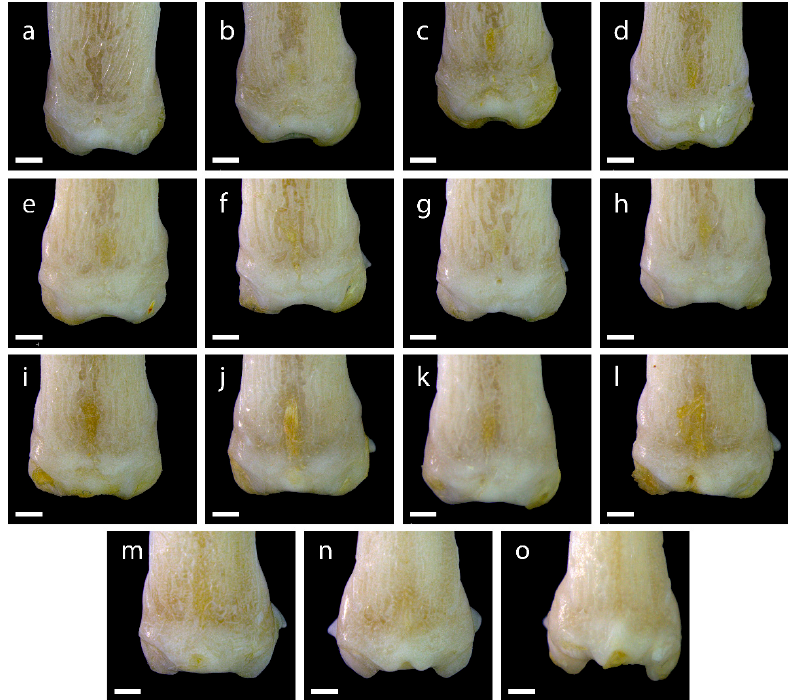
Figure A10. Microscopic images of the anterior view of the pinnules of P. bichir PO6. The images ( a – o ) correspond to the 1st, 2nd, 3rd, 4th, 5th, 6th, 7th, 8th, 9th, 10th, 11th, 12th, 13th, 14th, and 15th pinnules, respectively. Scale bars = 1 mm.